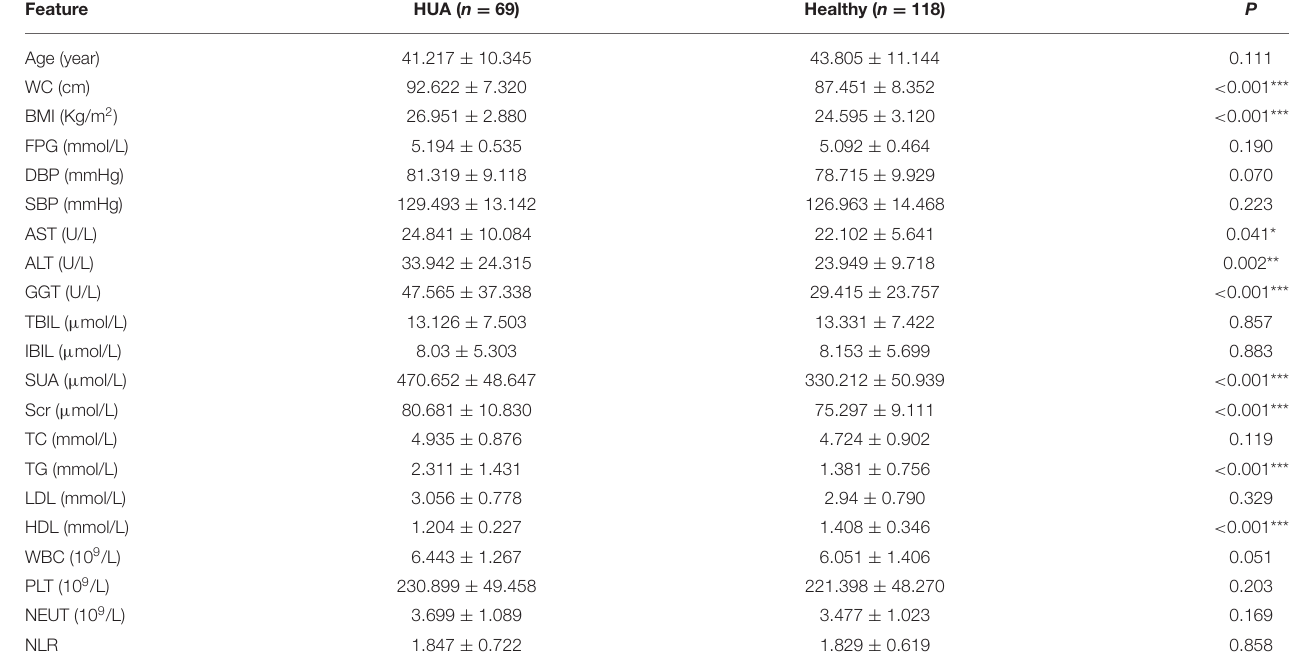
TABLE 1 | The major demographic and serum features in males of HUA group and healthy controls.